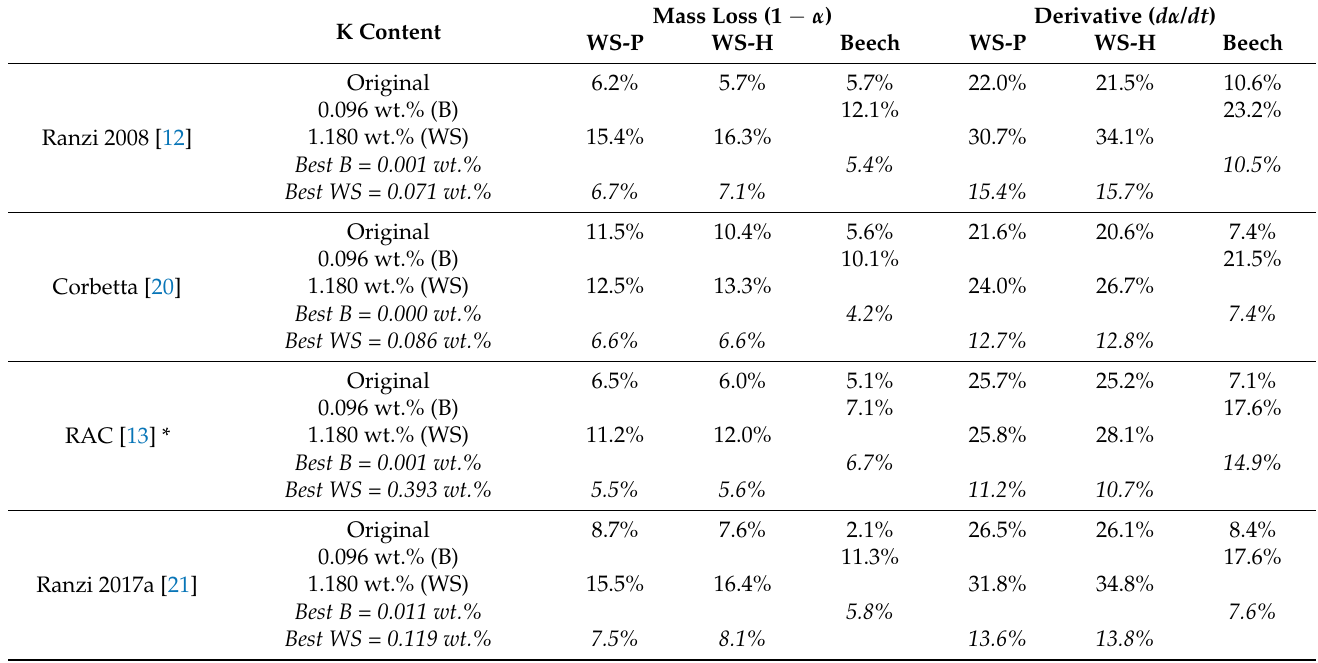
Table 13. Root sum of square errors between the (1 − α )/ d α / dt curves and the summative fits of curves based on literature-found reaction network kinetic values—including modifications by Trendewicz et al. [26]. Mass Loss (1 − α ) Derivative ( d α / dt ) K Content WS-P WS-H Beech WS-P WS-H